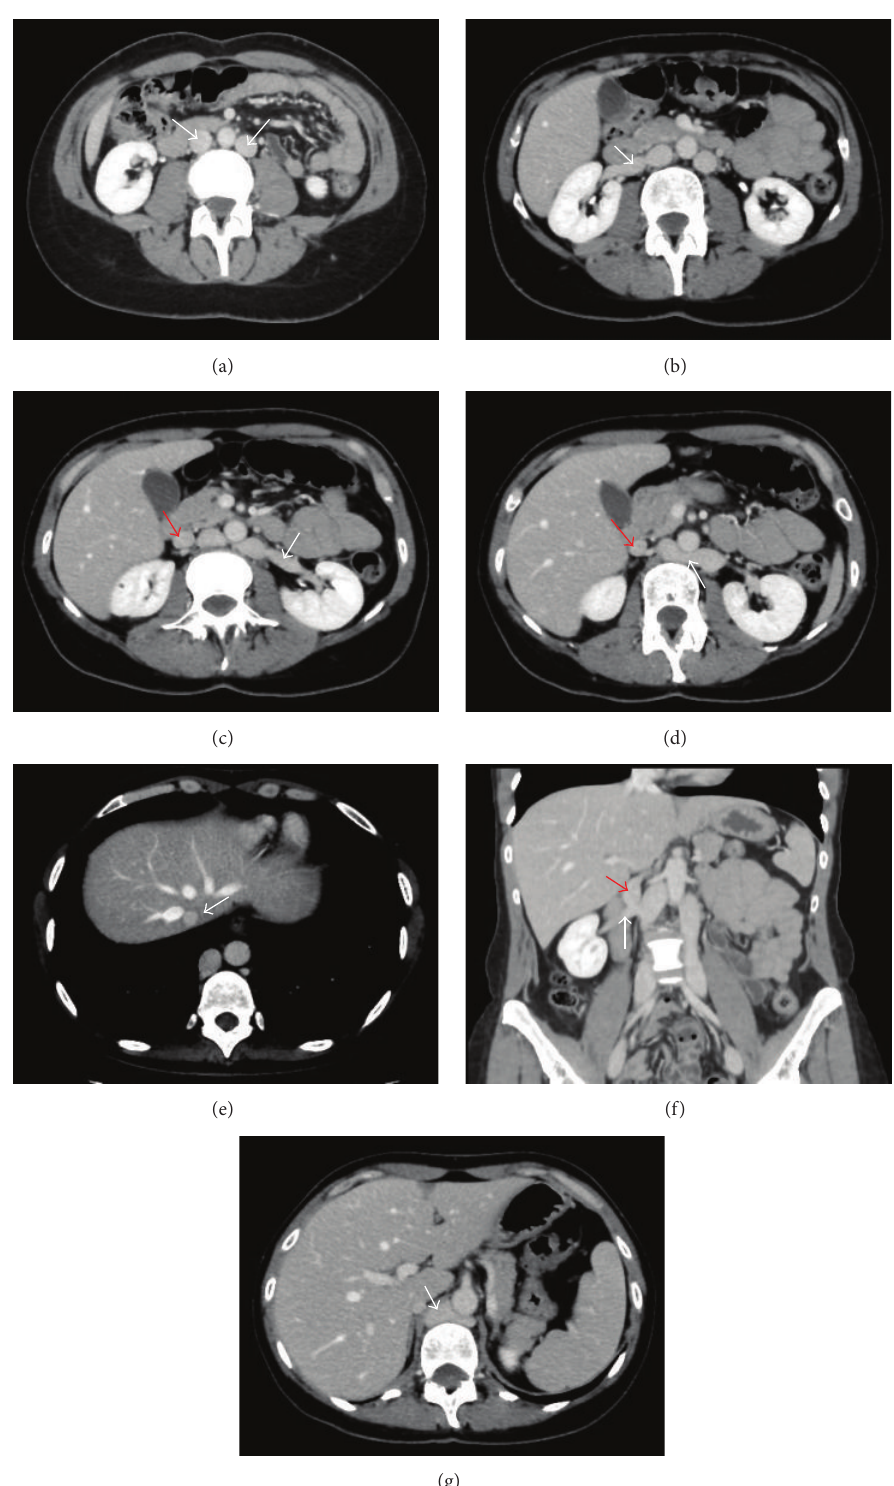
Figure 1: (a) CT axial images that presented from caudal to cranial sections show double IVC (arrows) below the renal veins. (b) The right IVC receives the right renal vein (arrow). (c) The left IVC receives the left renal vein (white arrow); presence of the hepatic portion (red arrow) of the IVC in the CT section before draining into the right renal vein. (d) The left renal vein (white arrow) crosses posterior to the aorta to join the right IVC; continuation of hepatic segment (red arrow). (e) The hepatic veins drain into a hypoplastic hepatic segment (arrow) of the IVC. (f) Coronal MPR image shows the hypoplastic hepatic segment (red arrow) draining into the right renal vein (white arrow), at the confluence with the right IVC. (g) The right IVC continues cephalad as the azygos vein (arrow) within the retrocrural